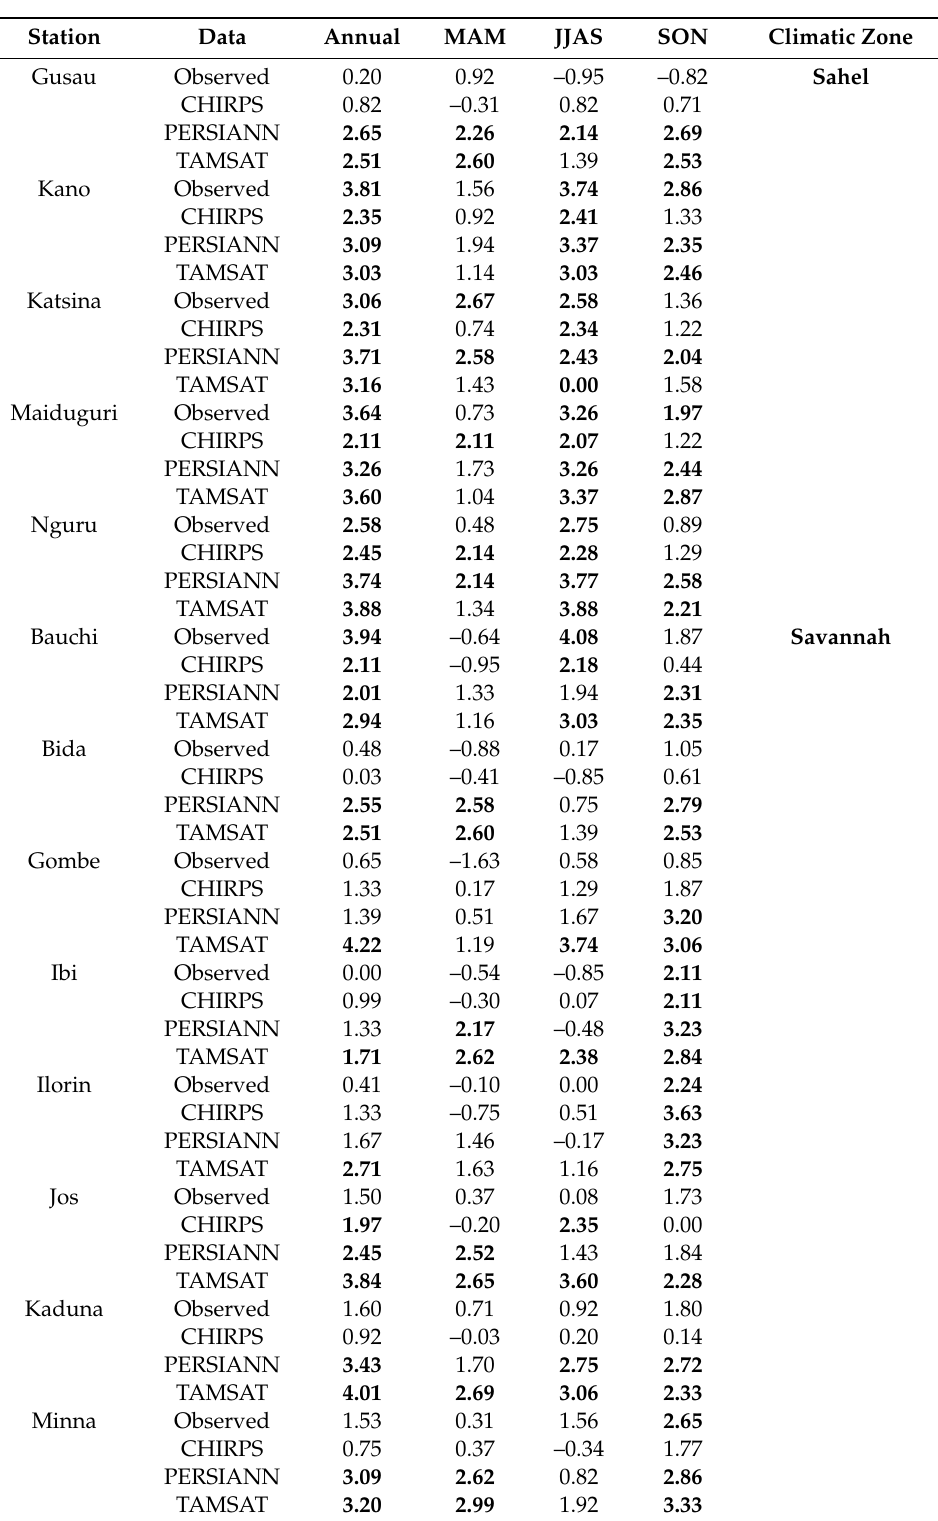
Table 5. Mann–Kendall statistics at annual and seasonal time series. JJAS =